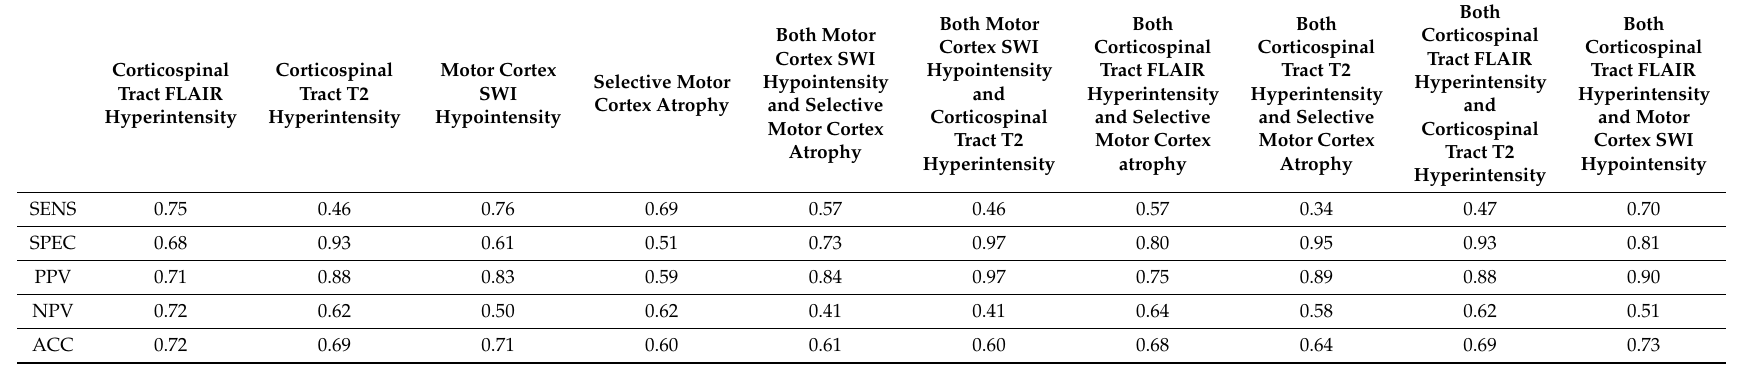
Table 4. Diagnostic accuracy of the significant MRI features, considered individually and